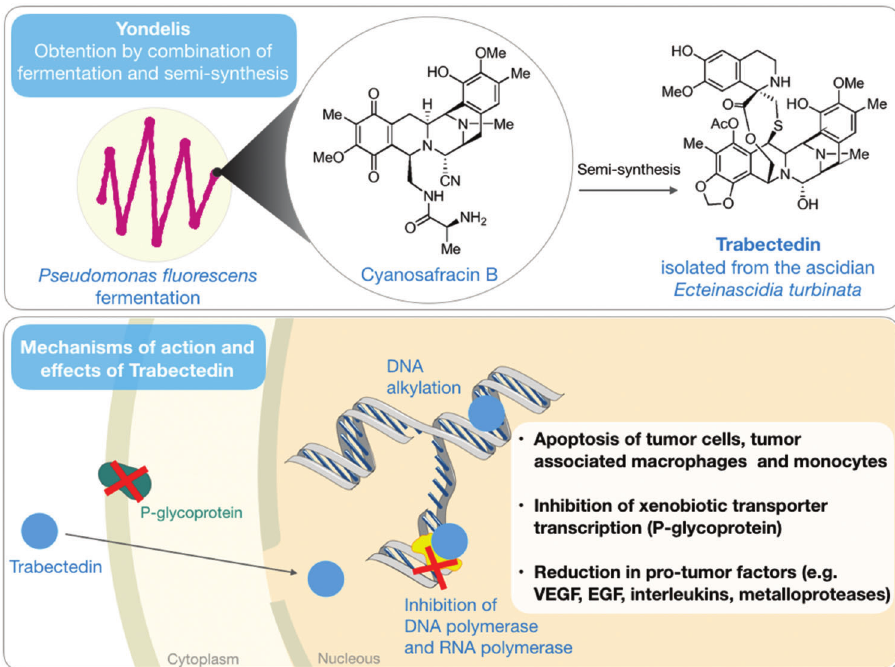
Figure 2 - Chemical structures of trabectedin isolated from the ascidian Ecteinascidia turbinata and its precursor cyanosafracin B isolated from the bacteria Pseudomonas fluorescens (top). A schematic representation of the mechanism of action of trabectedin in cancer cells